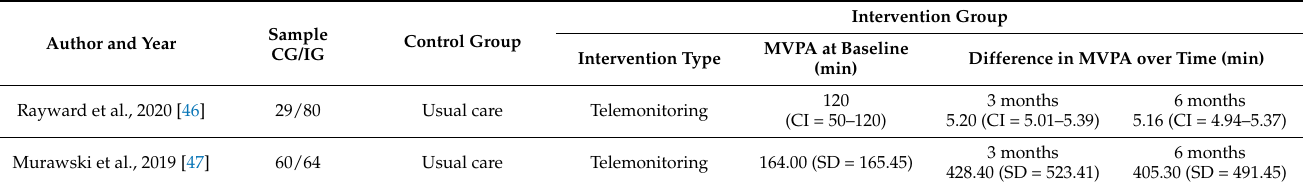
Table 5. Effects of telemedicine-based interventions in sedentary